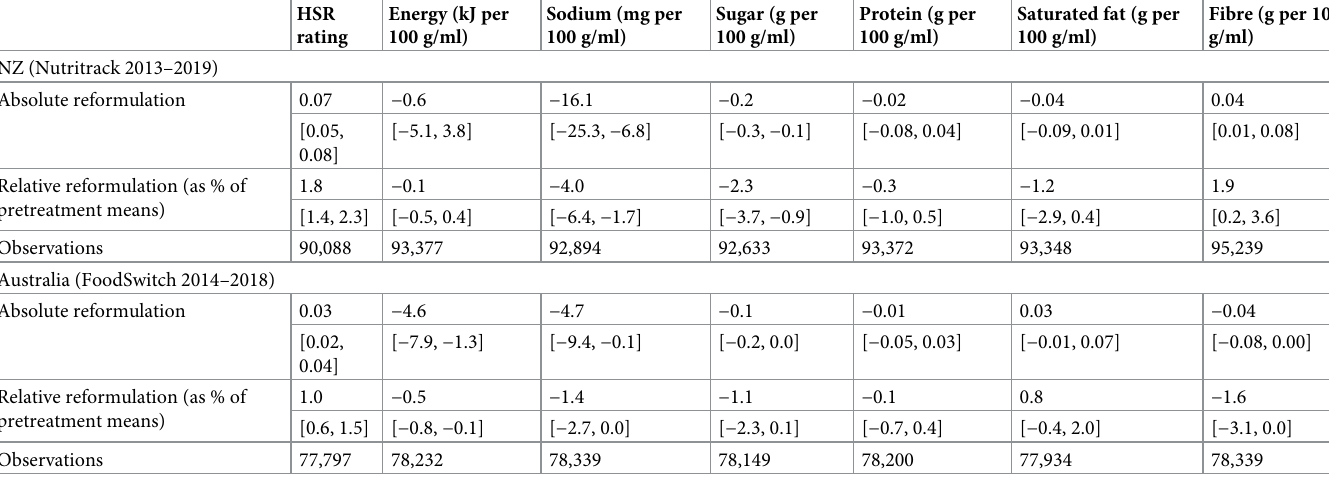
Table 2. Effect of voluntary adoption of HSR label on nutrient profile score and component nutrients controlling for market-wide trends and time-invariant prod- uct-level characteristics using fixed-effects